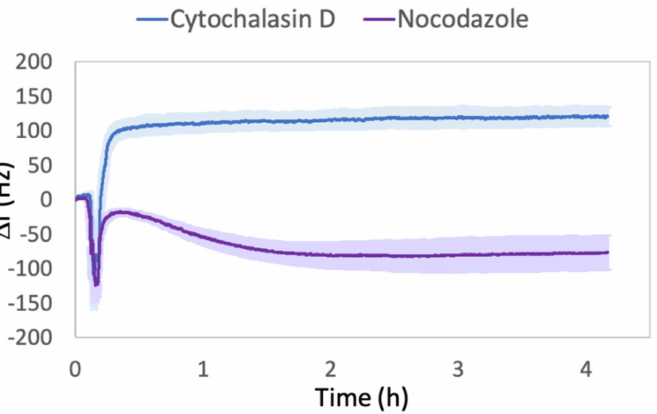
Figure 1. Comparison between frequency shifts ( ∆ f) of Cyt-D- and Noc-treated cells. The mean values are relative to three independent replicas performed with different sets of cells. The reported ∆ f values are relative to f signals recorded from 10 min before the drug solution injection (Cyt-D 5 µ M or Noc 10 µ M) until the end of four hours of